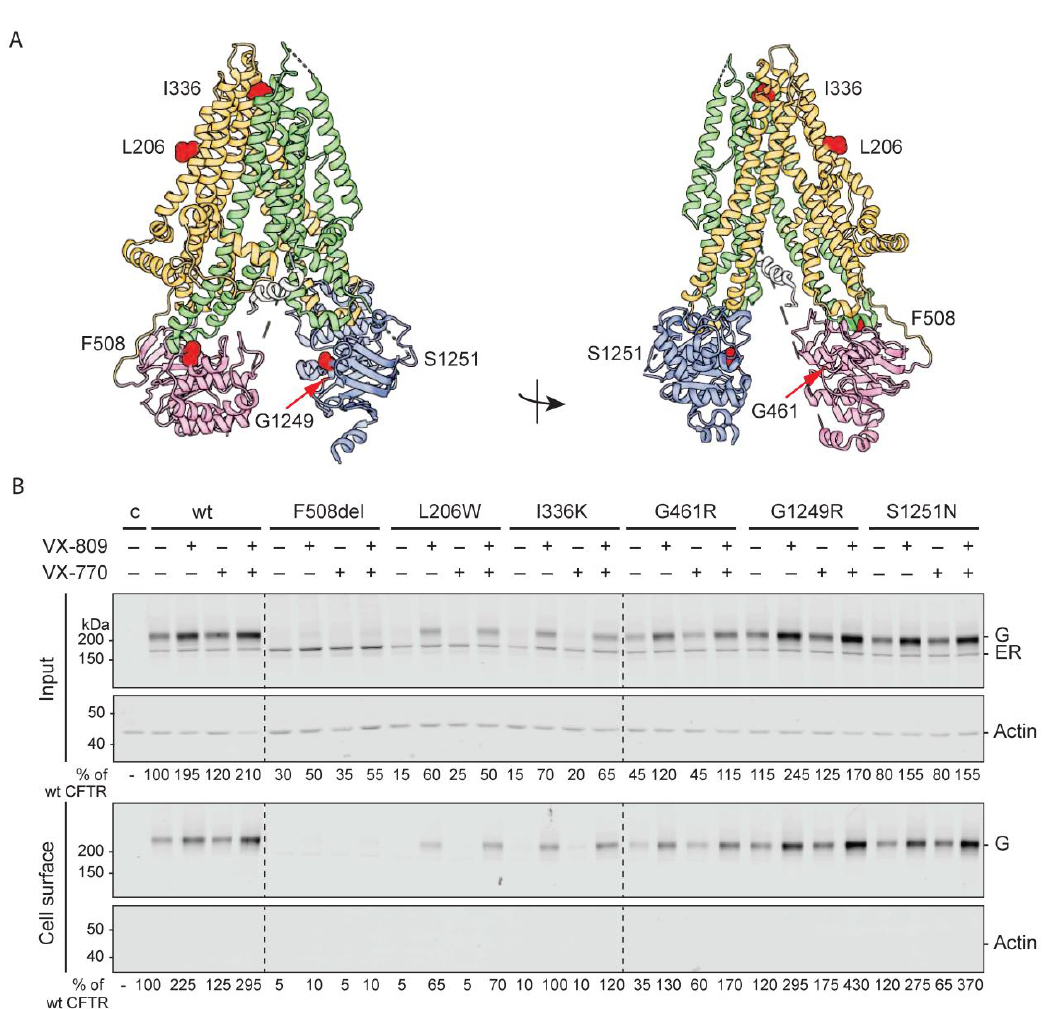
Figure 5. VX-809 strongly improves cell-surface levels of hyper-responding CFTR variants ( A ) Location of CF-causing mutations in the cryo-EM structure of CFTR (PDB: 5UAK) in color- coded CFTR domains (TMD1 in orange, NBD1 in pink, R-region in grey, TMD2 in green, and NBD2 in blue). ( B ) HEK293T cells expressing wild-type CFTR or indicated CFTR mutants were pre-incubated for 18 h with 3 µ M VX-809 and/or for 15 min with 3 µ M VX-770. CFTR was analyzed as in Figure 1B. Gels are representative of at least three independent experiments. Quantifications are below each lane and used for plots